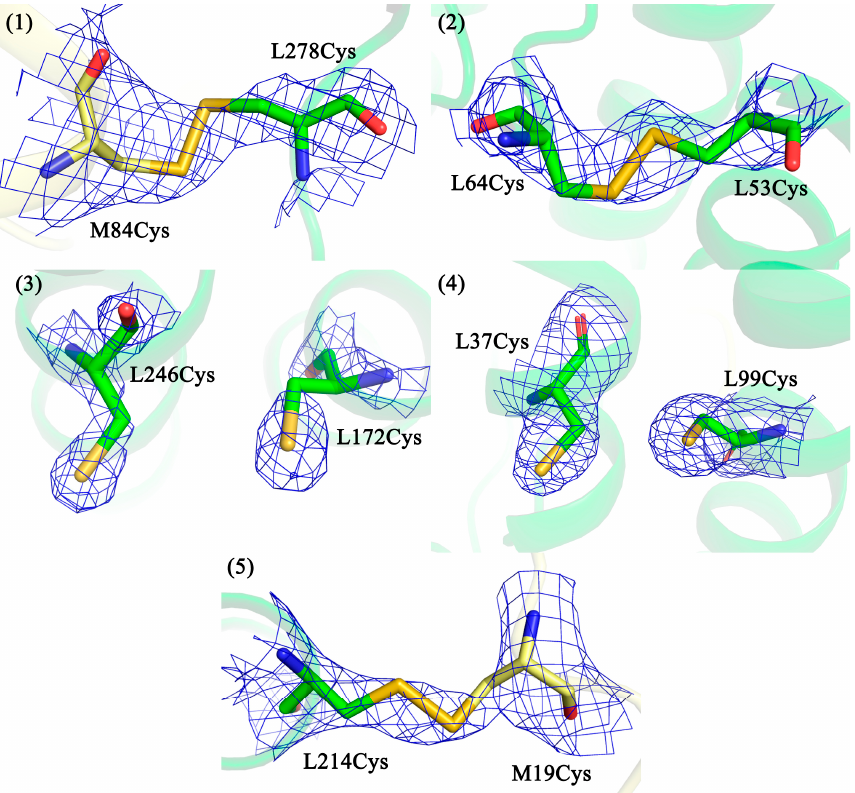
Figure 2. Fragments of the 2Fo-Fc electron density maps for the crystal structures of the RC mutant forms at the sites of amino acid substitutions: (pair 1) V(M84)C+G(L278)C mutant form, 2.6 Å resolution, 0.7 σ ; (pair 2) A(L53)C+I(L64)C mutant form, 2.85 Å resolution, 2.0 σ ; (pair 3) A(L172)C+L(L246)C mutant form, 2.3 Å resolution, 2.1 σ ; (pair 4) A(L37)C+S(L99)C mutant form, 2.6 Å resolution, 2.0 σ ; (pair 5) G(M19)C+T(L214)C mutant form, 2.75 Å resolution, 1.2 σ